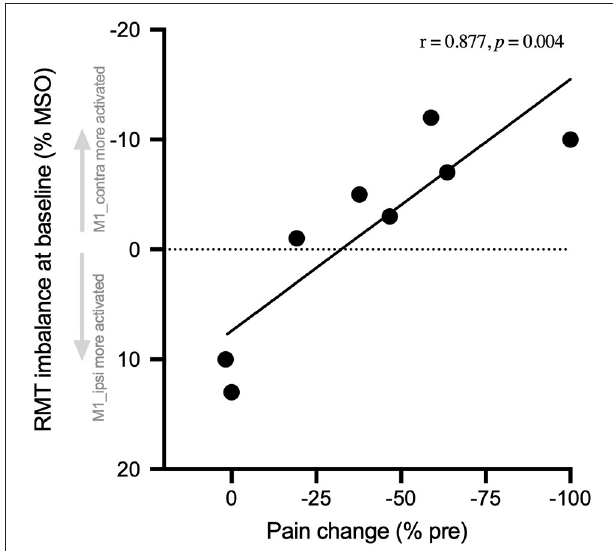
FIGURE 4 | Pain change correlated with baseline RMT hemispheric balance. The number of changes of instant pain at post-rPMS (% pre-rPMS) is expressed against the raw hemispheric imbalance of RMT at pre-rPMS (% MSO). This imbalance was calculated as the difference of RMT between M1 contralateral to the CRPS side (M1_contra) and M1 ipsilateral (M1_ipsi). Thus, the negative values (above 0, Y-axis reversed) indicate the participants with baseline RMT that was lower for M1_contra (i.e., M1_contra excitability higher than M1-ipsi). The more M1-contra was activated as compared to M1_ipsi at baseline, the more instant pain was reduced after rPMS. RMT, resting motor threshold, MSO, maximal stimulator